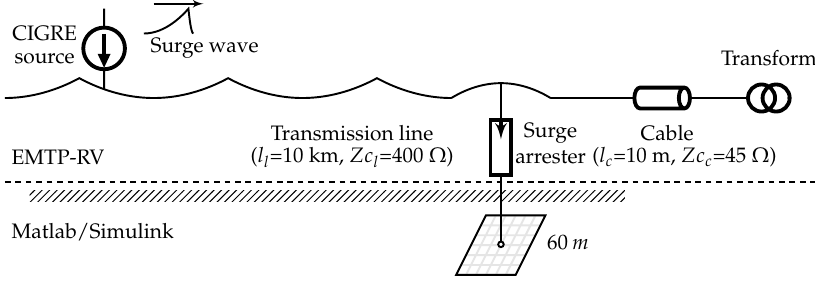
Figure 6. Simplified illustration of implemented transmission and grounding